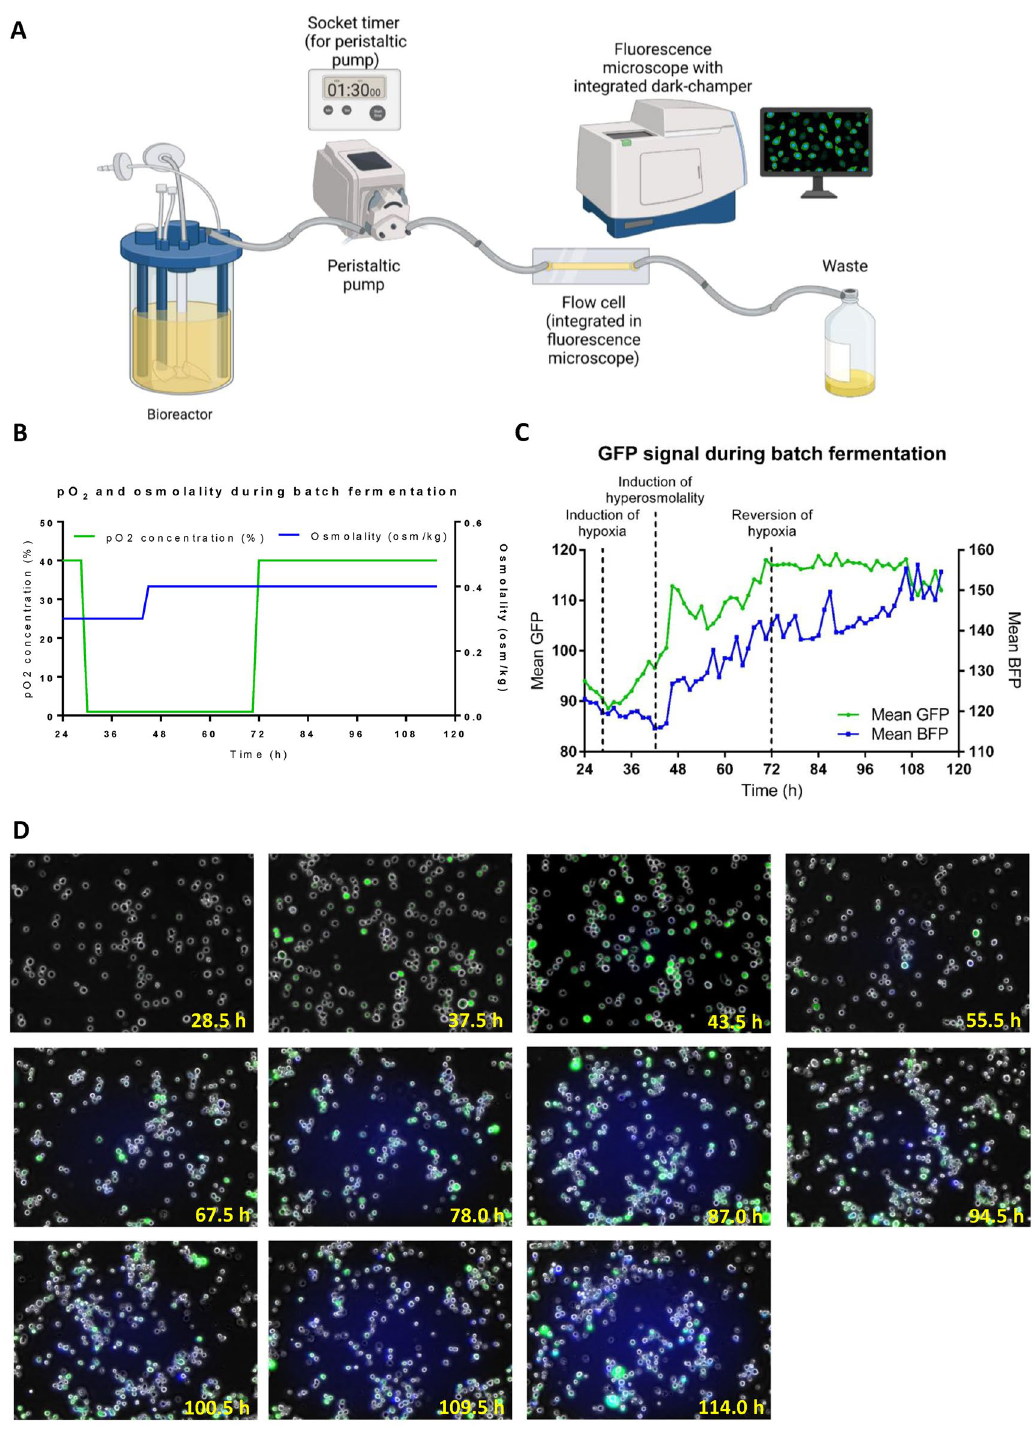
Figure 4. Automated real-time monitoring of a CHO multiplex sensor cell line during batch fermentation. ( A ) Schematic experimental setup. ( B ) Osmolality and pO 2 concentration during batch fermentation. ( C ) d2GFP and FKBP-BFP signals of CHO-DG44 cells during batch fermentation recorded by image cytometry at 90 min intervals. ( D ) Representative fluorescence microscopy images of CHO-DG44 cells during batch fermentation recorded at 90 min